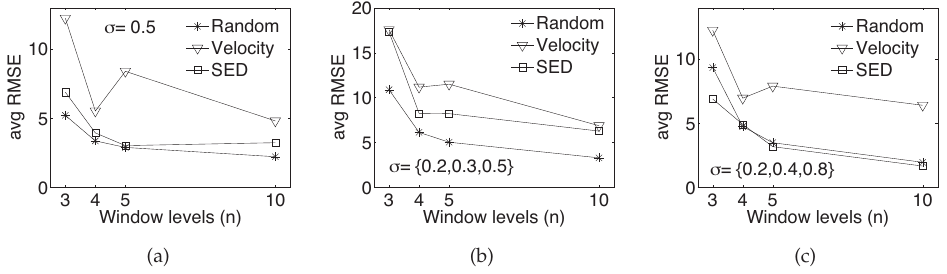
Figure 13: Average RMSE for varying numbers of window levels in nested